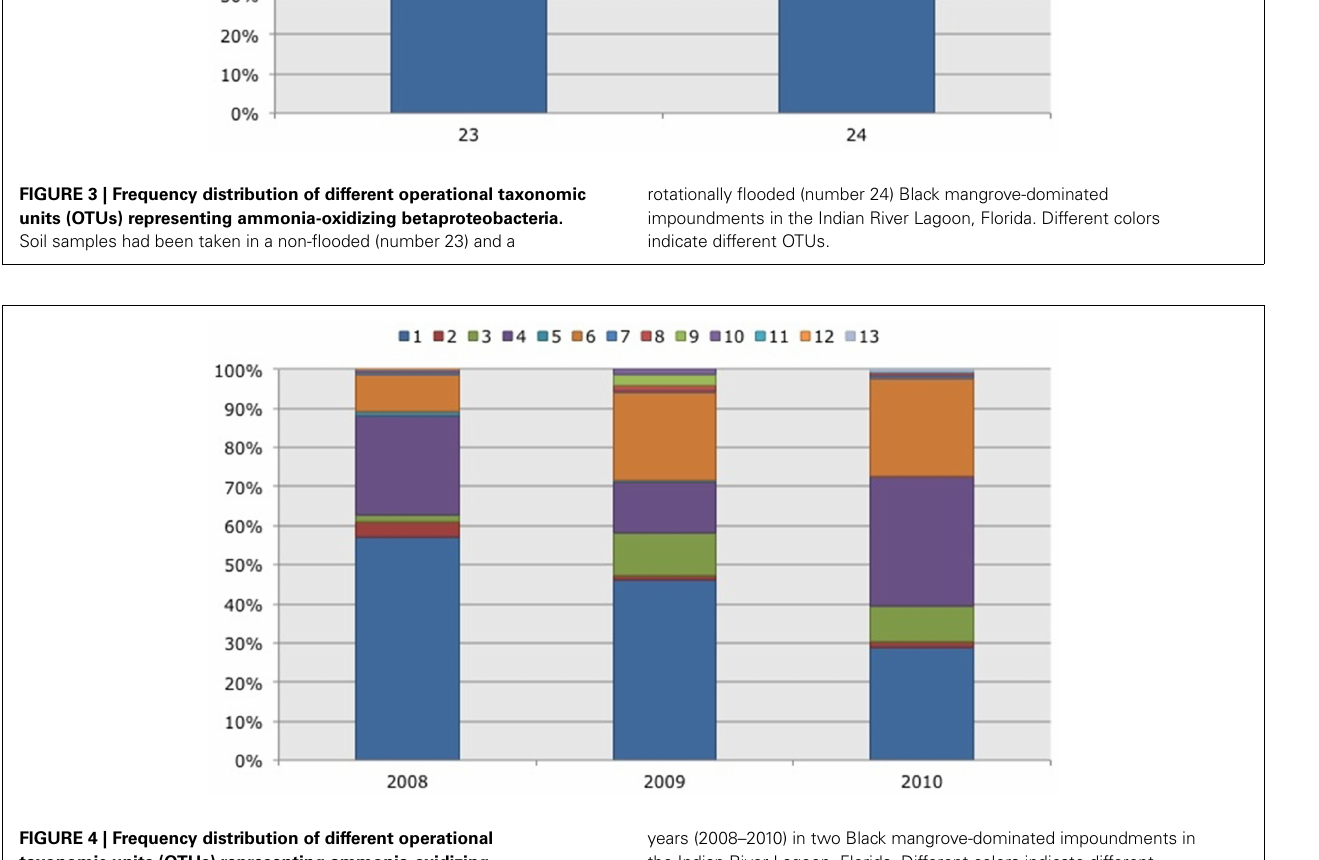
FIGURE 4 | Frequency distribution of different operational taxonomic units (OTUs) representing ammonia-oxidizing betaproteobacteria. Soil samples had been taken in three subsequent